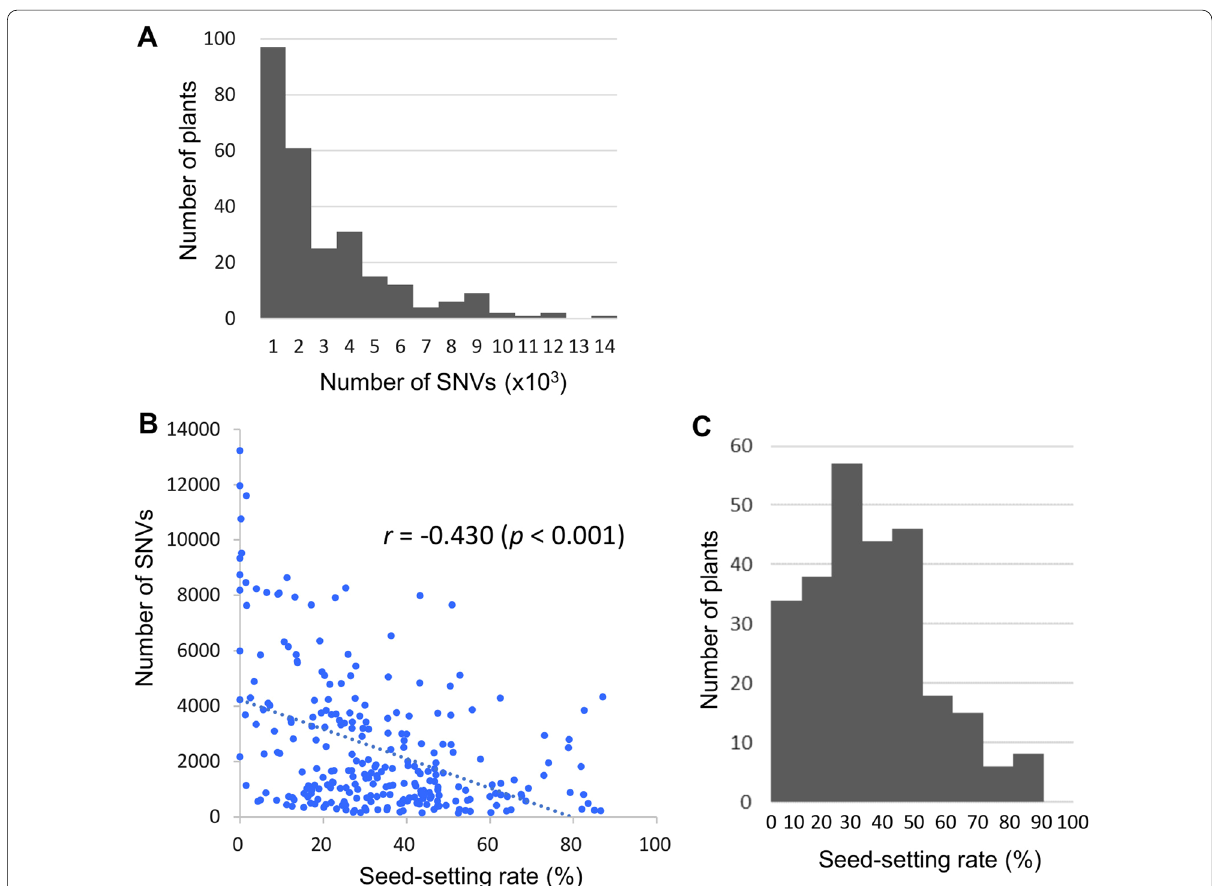
Fig. 3 Correlation between the seed-setting percentage and the mutation frequency in the M 1 population ( N identified on 266 M 1 genomes. B Correlation between the seed-setting percentage and the number of SNVs. C Distribution of the seed-setting percentage of the M 1